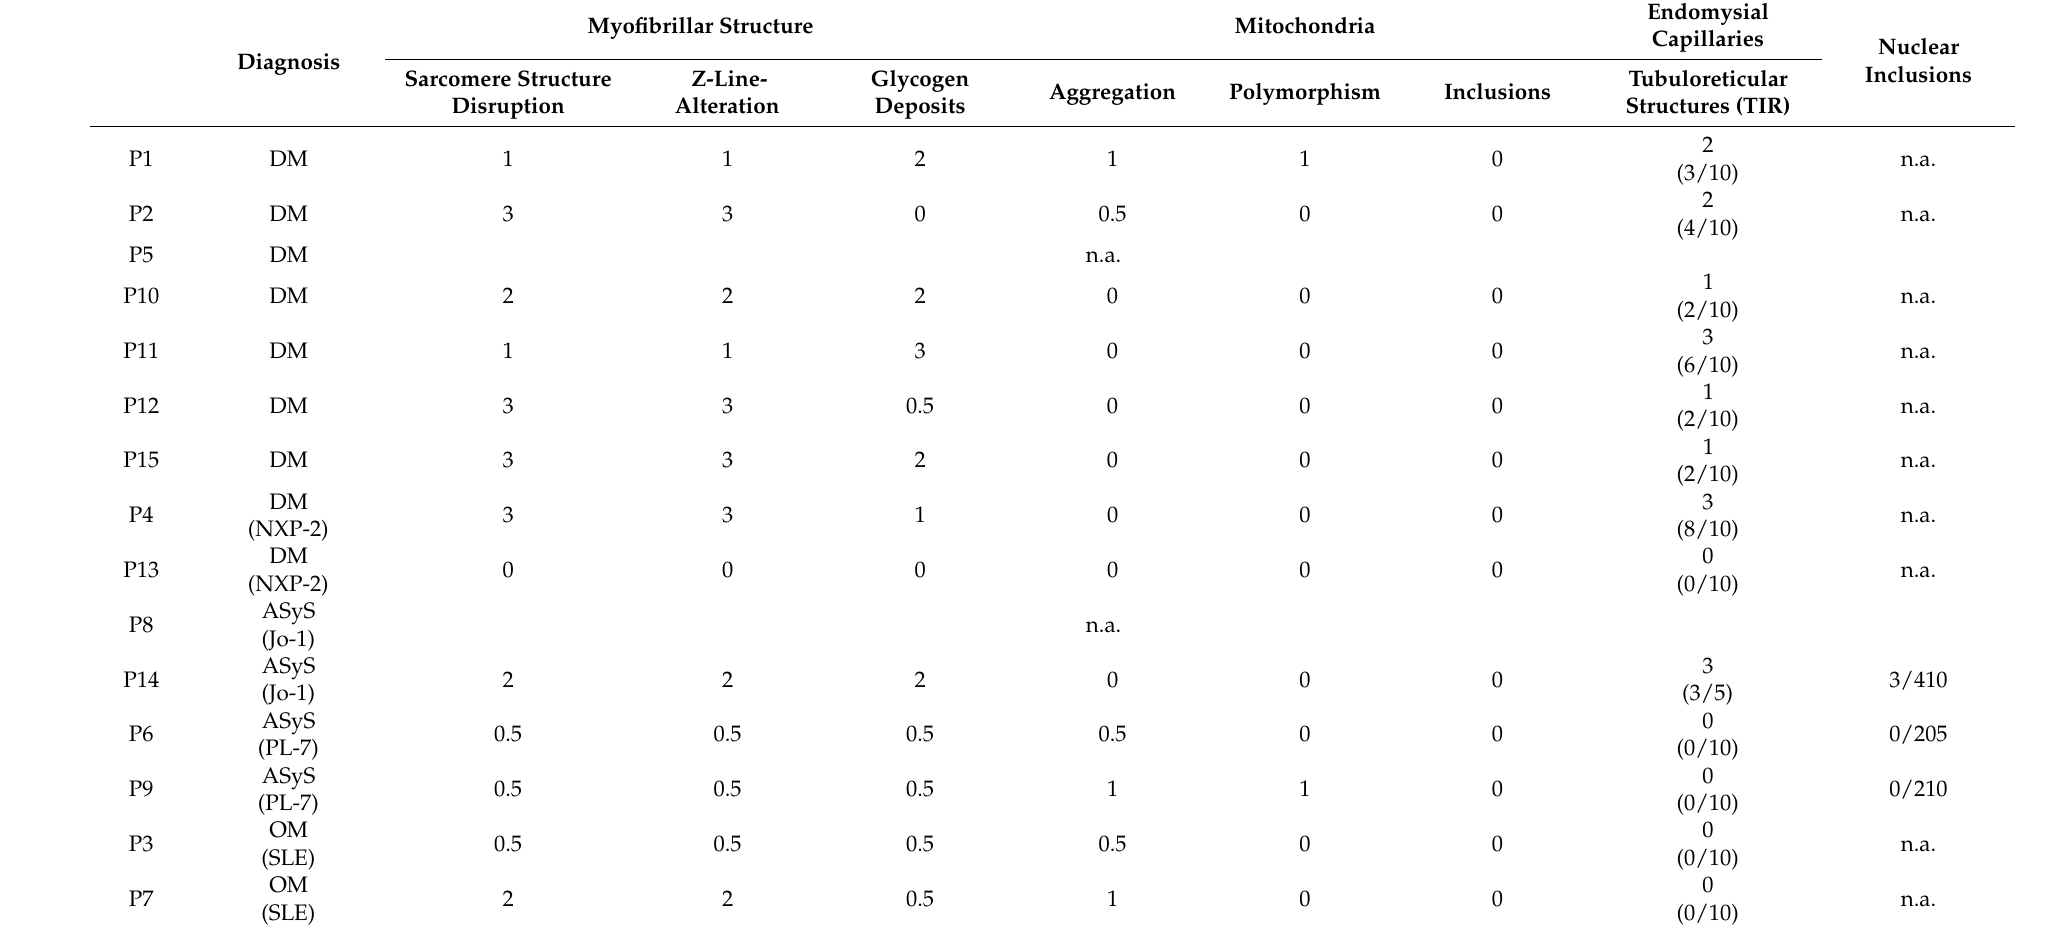
Table A3. Scoring of muscle pathology at ultrastructural